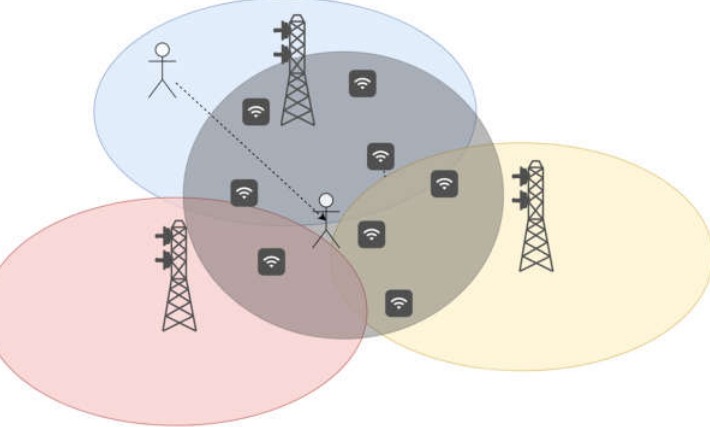
Figure 3. Sample visualization of cellular network coverage (e.g., 4G/LTE, which coverage is overlaid by another RAT, e.g., Wi-Fi).